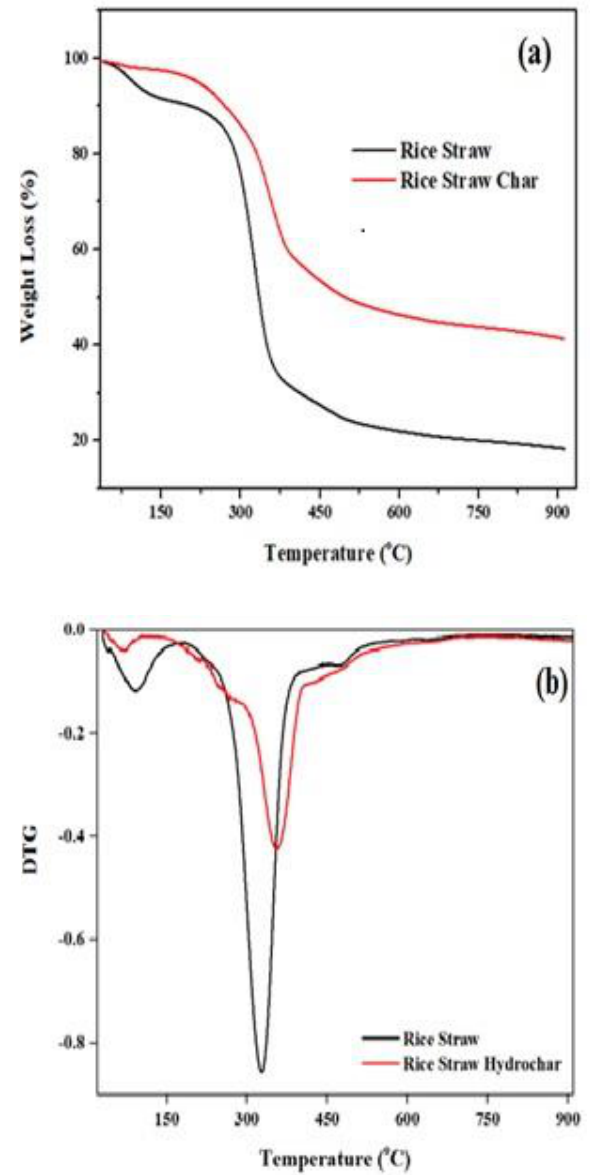
Figure 9. ( a ) The TGA analysis and ( b ) DTG analysis of rice straw and optimized hydrochars.